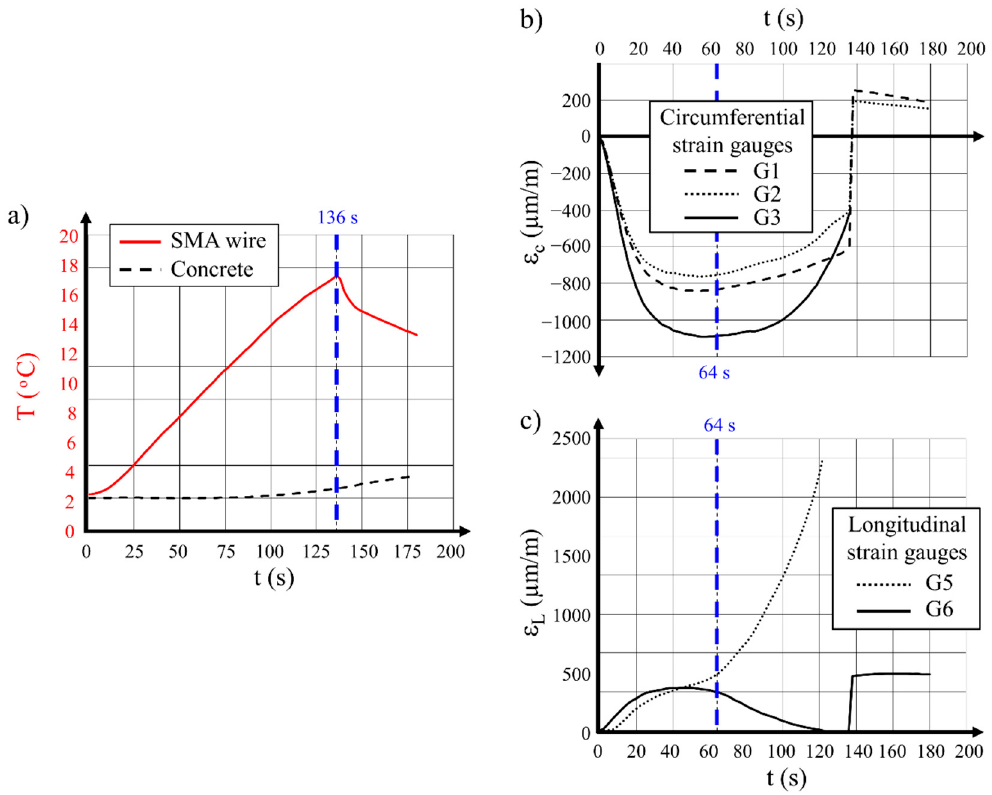
Figure 8. Results recorded during testing of the 300 mm hollow cylinder prestressed with 3 mm SMA wire—specimen R2: ( a ) temperature variations of the wire and of the concrete specimen internal surface over time; ( b ) strain variations of concrete in the circumferential direction over time; ( c ) strain variations of concrete in the longitudinal direction over time.